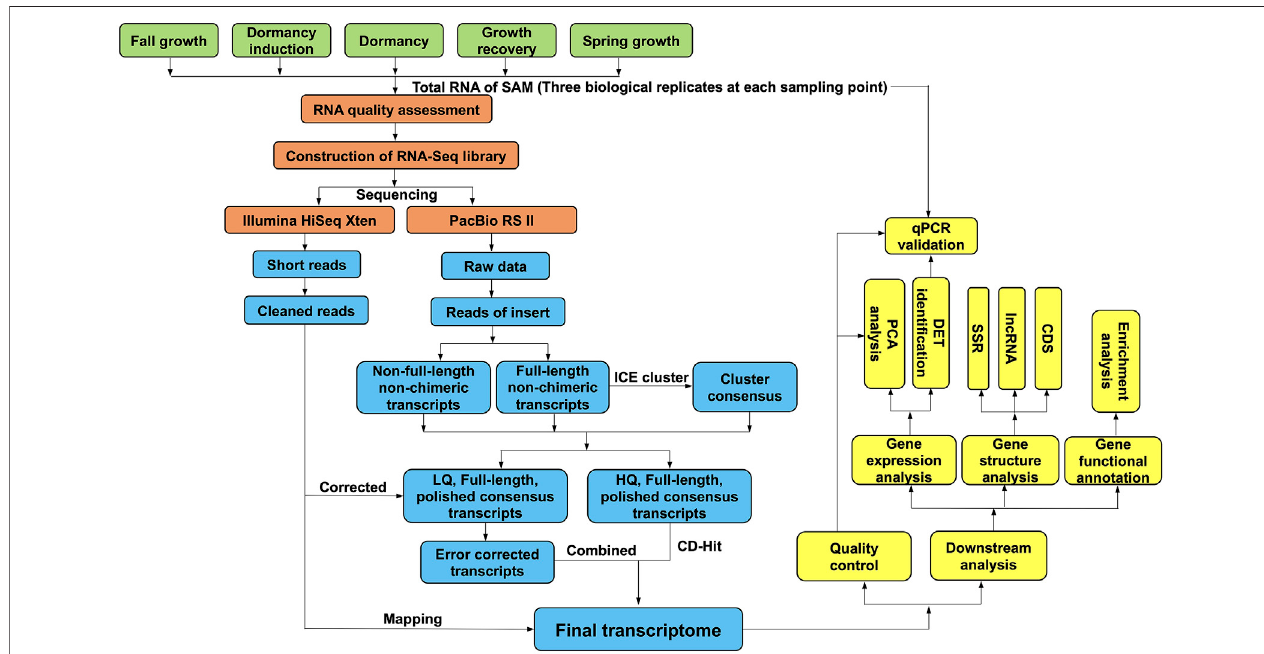
FIGURE1 | Overview of the experimental design and analysis pipeline. The RNA samples of Japanese iris from fi ve crucial developmental stages related to winter dormancy were sequenced both by Pacbio Iso-seq and Illumina short read RNA-seq. The raw data from a Pacbio RS II sequencer was classi fi ed and corrected to generate the high-quality full-length transcripts (FLTs). The FLTs were used for gene annotation and structure analysis. Then the Illumina clean data were mapped to the FLTstocalculatethereadcountsofeachtranscriptbyRSEMandusedtoidentifythedifferentiallyexpressedtranscriptswithDESeqRpackage.Thesamplestage was determined by the observation of shoot growth or dormancy